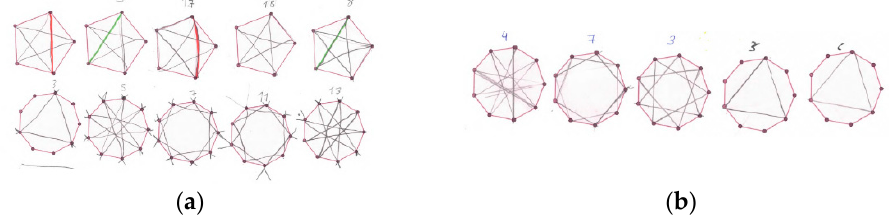
Figure 6. Star polygons. Drawing made by participant: ( a ) A2 (similar to the one made by A1); ( b ) A3.